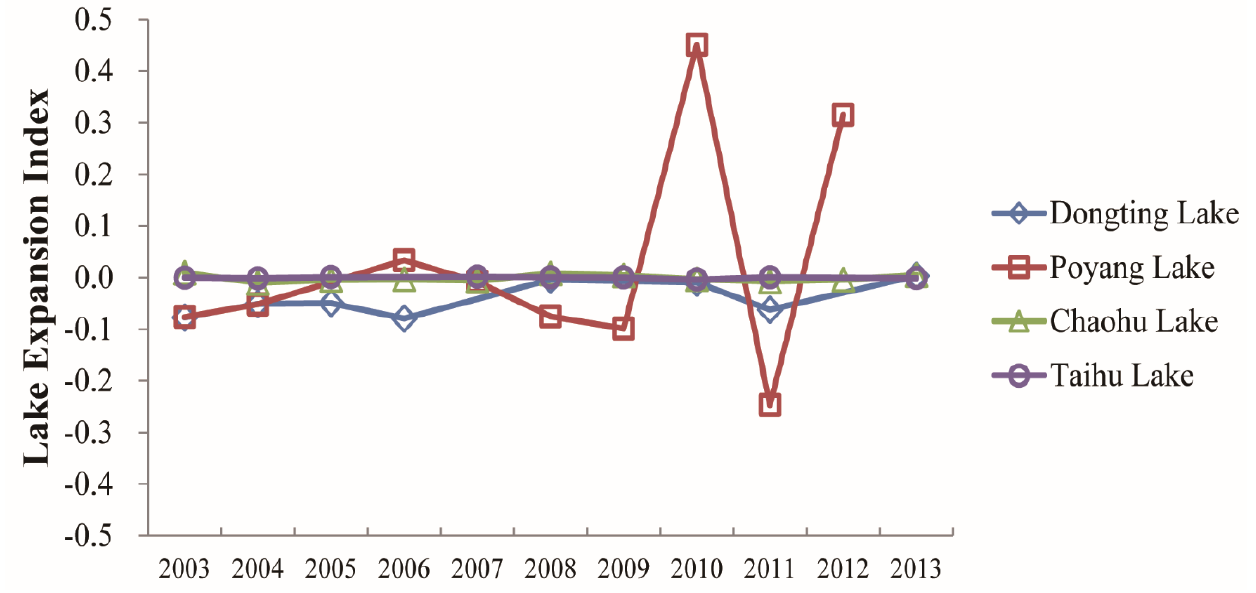
Figure 4. The LEI of the four lakes from 2002 to